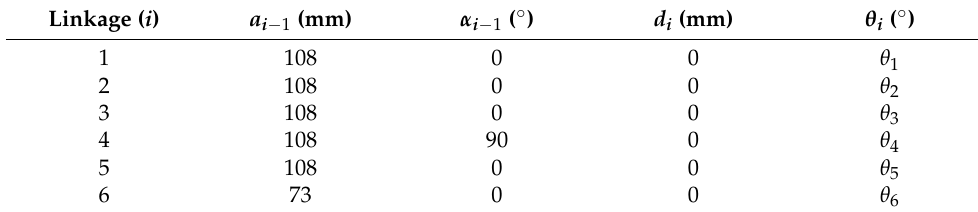
Table 1. The D-H parameters of CDFM.